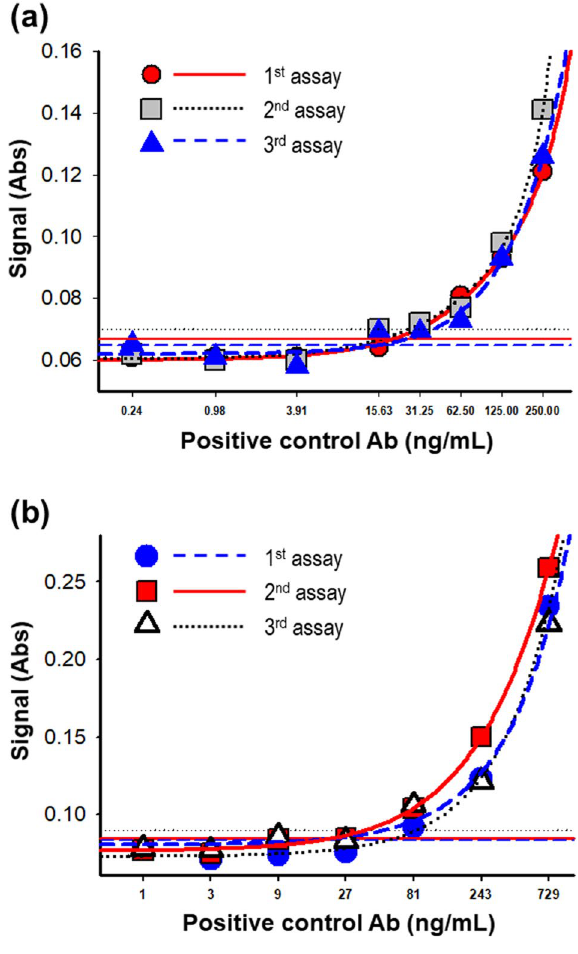
Figure 3. Estimation of assay sensitivity. ( a ) Assay sensitivity was measured in rat sera. PC were spiked into pooled rat serum samples at concentrations ranging from 0.24 to 250 ng/mL. ( b ) For monkey serum, PC were prepared at concentrations ranging from 1 to 729 ng/mL. The lowest concentration at which the absorbance value was equal to the normalized NCO value in each trial is shown for each sensitivity